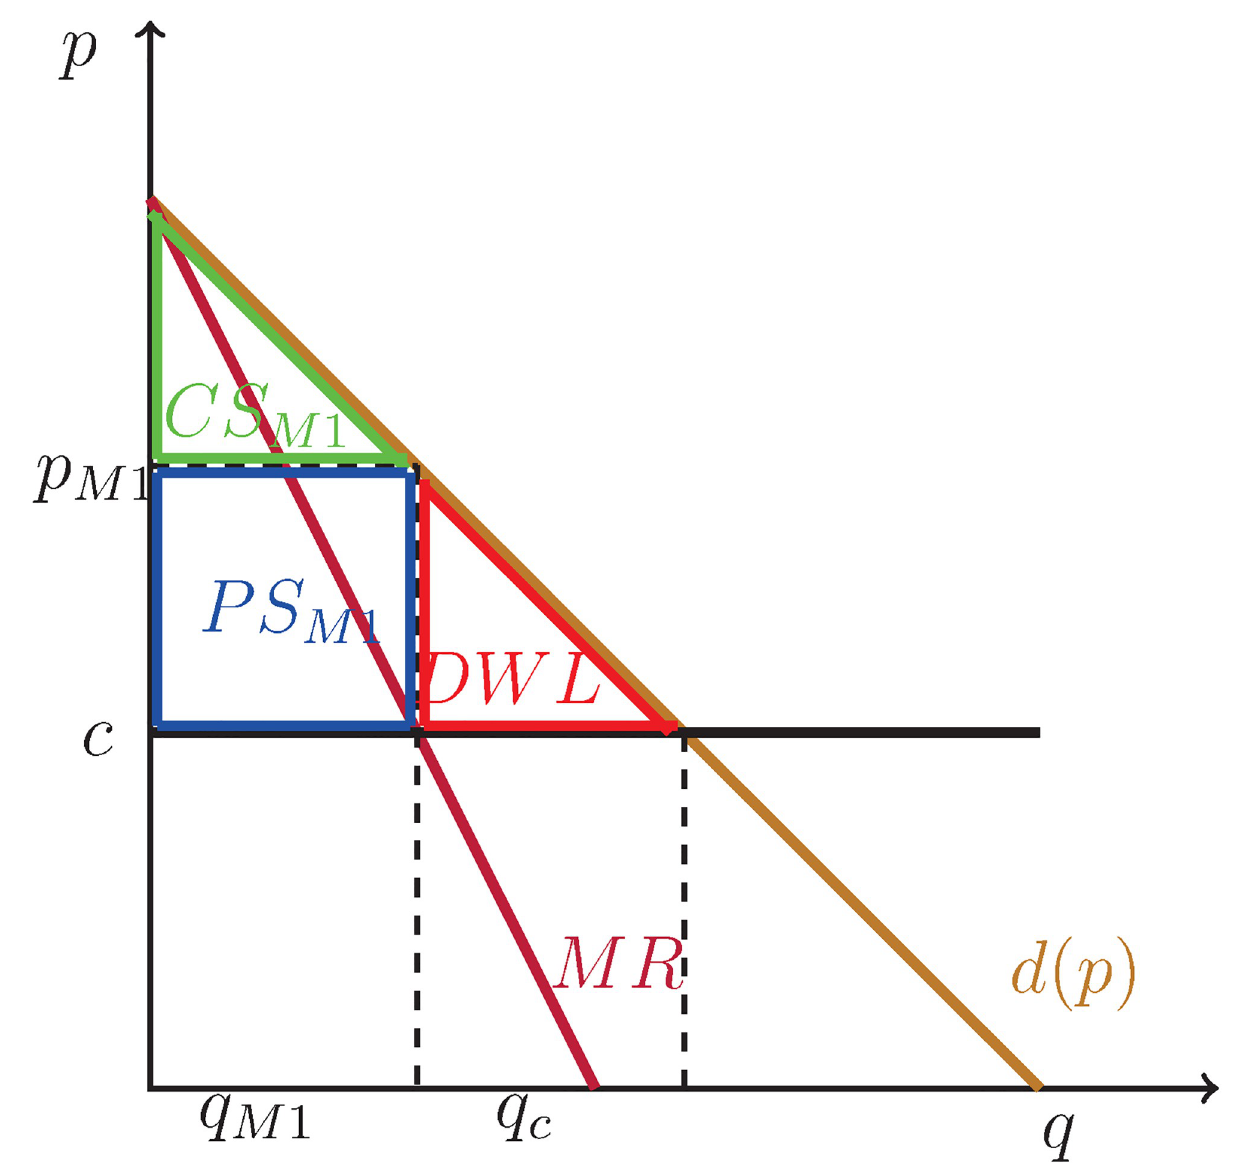
Fig 1. Case 1, market 1: Monopoly with constant marginal